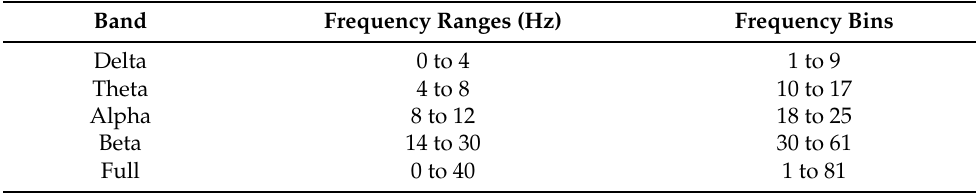
Table 1. Band power features and the corresponding frequency